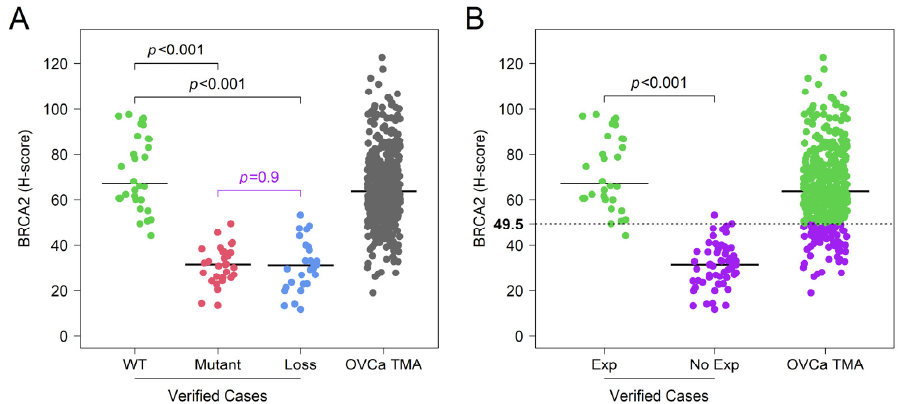
Figure 2. BRCA2 protein expression in the sequenced ovarian tumor cases and un-sequenced TMAs. ( A ) C-terminal expression of the BRCA2 wildtype (WT) is statistically different compared to BRCA2 mutant (Mutant) and BRCA2 loss (Loss) in the sequenced ovarian tumor cases, but there is no statistical difference between the Mutant and Loss cases. This was plotted alongside the distribution of un-sequenced TMA H-scores. ( B ) For the sequenced ovarian tumor cases, BRCA2 C-terminal expression of the WT was categorized as BRCA2 expressors (Exp) while those of the Mutant and Loss were grouped as BRCA2 non-expressors (No Exp). An optimal cutoff point of 49.5 was determined based on the C-terminal expression levels of the sequenced ovarian tumor cases and was used to stratify the un-sequenced ovarian cancer TMA (OVCa TMA) H-scores into Exp and No Exp.